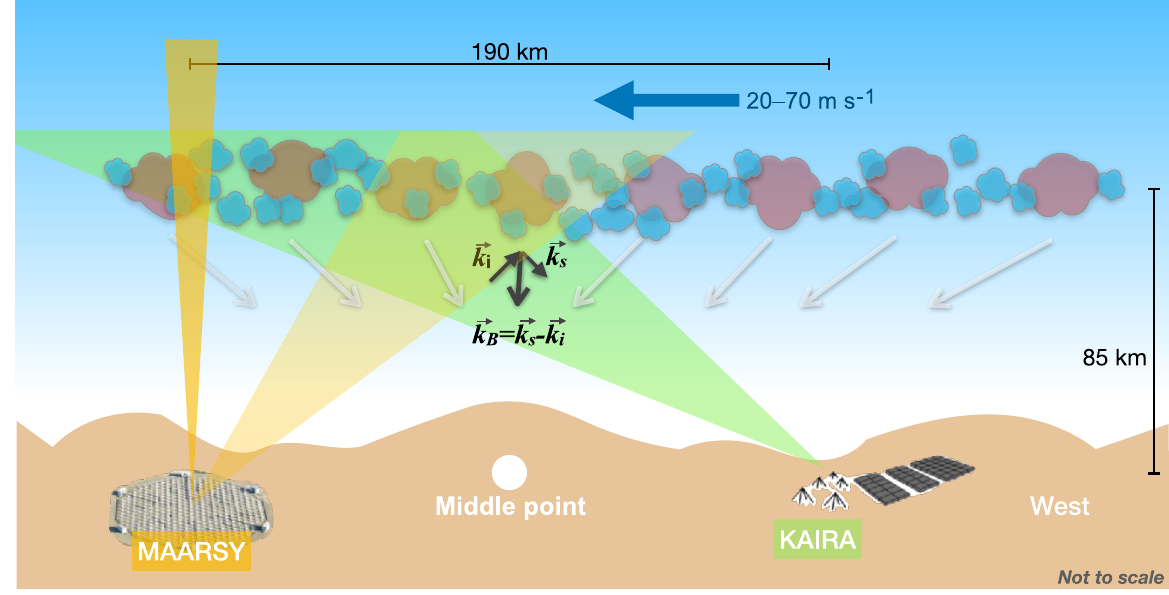
Figure 2. Sketch of PMSE observations with MAARSY as transmitter and KAIRA and MAARSY as receivers. MAARSY main lobe and side lobes are represented by the vertical and tilted yellow triangles, respectively. The region of PMSEs is depicted with clouds of different sizes and colors located in a narrow region. The white arrows represent the expected Bragg vectors of the MAARSY–KAIRA detections (see text for more